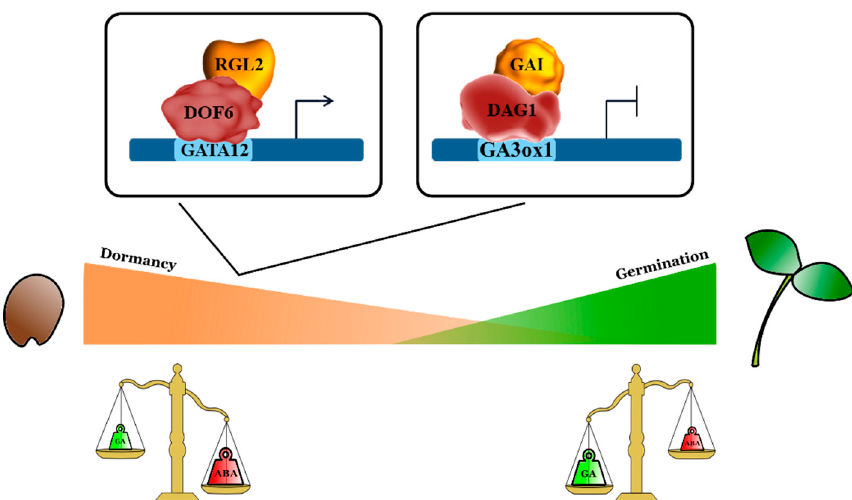
Figure 1. DOF proteins interact with DELLA factors to negatively regulate seed germination. On the left: the Arabidopsis DOF6 protein (AT3G45610; DOF3.2) interacts with the DELLA protein RGL2. The complex RGL2-DOF6 induces GATA12 expression, in freshly harvested seeds, to establish seed dormancy [64]. On the right: the Arabidopsis DAG1 protein requires the DELLA protein GAI to repress the GA biosynthetic gene GA3ox1 during maturation, dormancy and germination of seeds [75]. RGL2 (RGA LIKE2), GAI (GA INSENSITIVE).